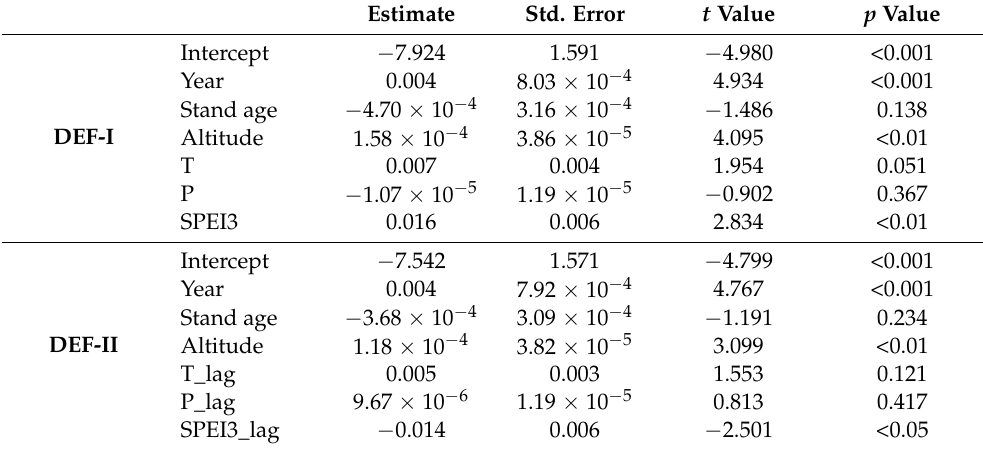
Table 1. Estimated model parameters, standard errors, t -values, and p -values for mean defoliation LMM models with current year (DEF-I) and previous year climate variables (DEF-II). T—mean annual temperature, P—annual sum of precipitation, SPEI3—mean annual Standardized Precipitation Evapotranspiration Index calculated on a three-month time scale, lag—denotes previous year values.